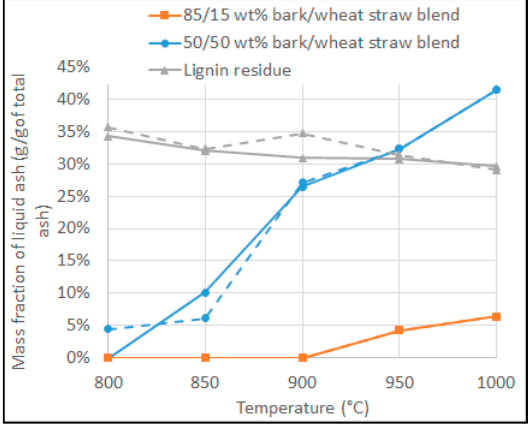
Figure 10. Mass fraction of liquid ash in total ash as a function of temperature in steam gasification (dotted lines) and air oxidation conditions (full lines).